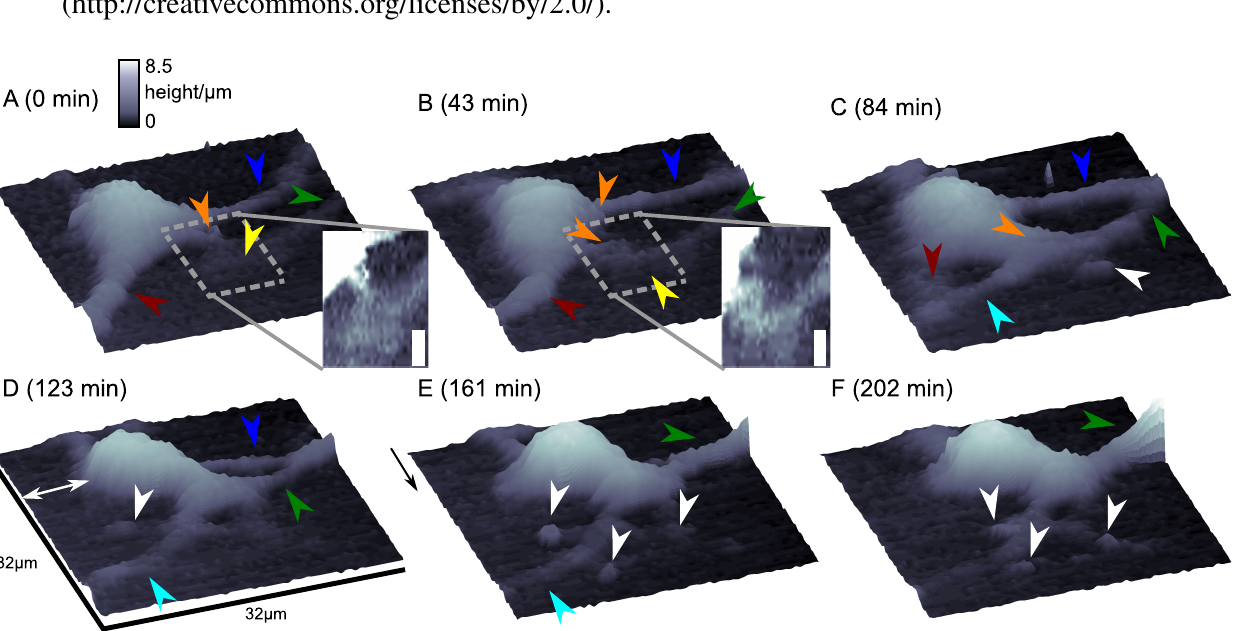
Long term imaging of a living neural cell from rat brain. Images were obtained in backstep (hopping/STA) mode at times as